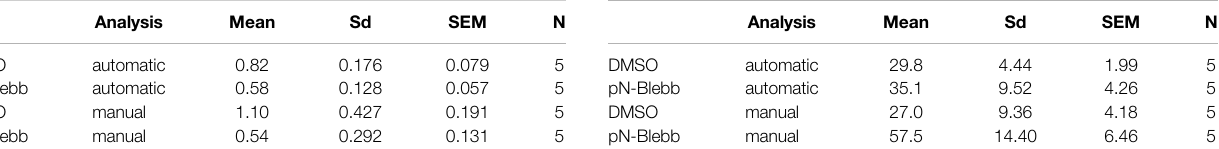
TABLE 1 | Signal increase after stimulation. TABLE 2 | Endocytic time constant